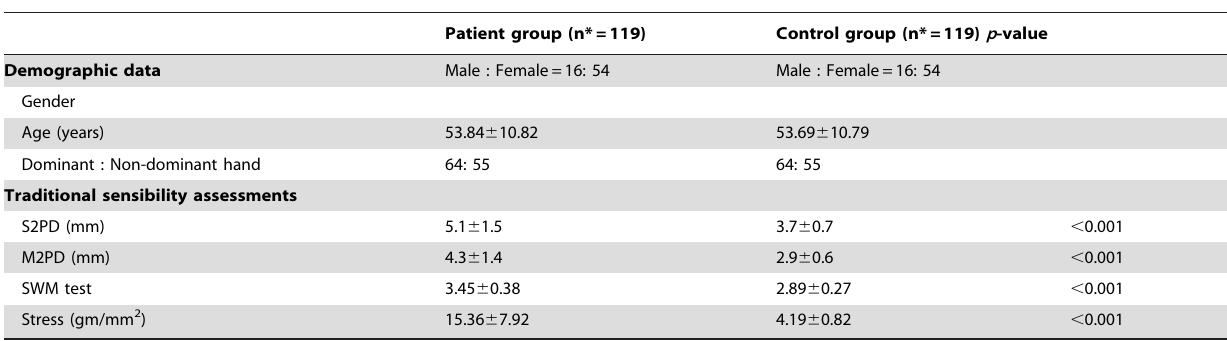
Table 1. Demographic data of patient and control